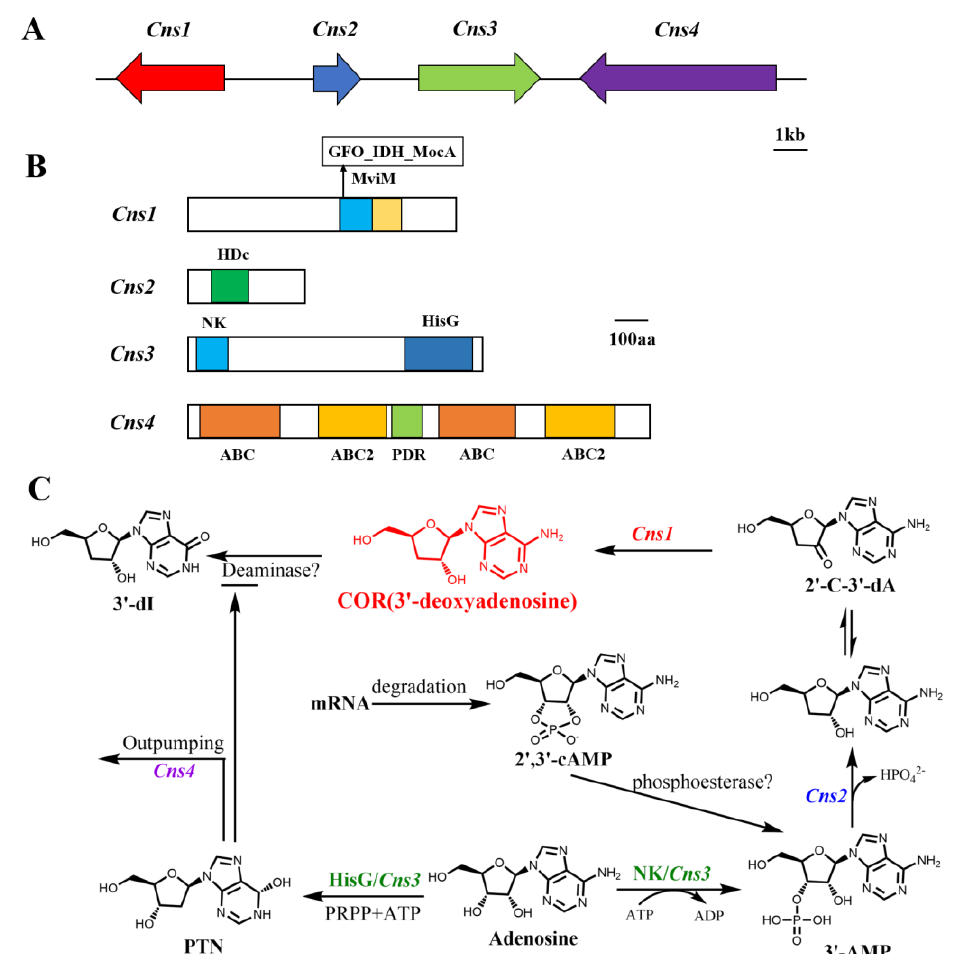
Figure 2. Delineation of COR biosynthetic gene cluster and the COR biosynthesis pathway [63]. ( A ) The gene cluster for synthesize cordycepin C. militaris . ( B ) Schematic structure of the proteins. ( C ) Delineation of the biosynthetic pathway of cordycepin. Abbreviations: PRPP, phosphoribosyl pyrophosphate; 2′ -C- 3′ - dA: 2′ -carbonyl- 3′ - deoxyadenosine; 2′,3′ -cAMP: 2′,3′ -cyclic monophosphate; NK: an N-terminal nucleoside kinase; HisG: a C-terminal HisG family of ATP phosphoribosyltransferases; PTN: pentostatin; 3 ′ - dI: 3′ -deoxyinosine.